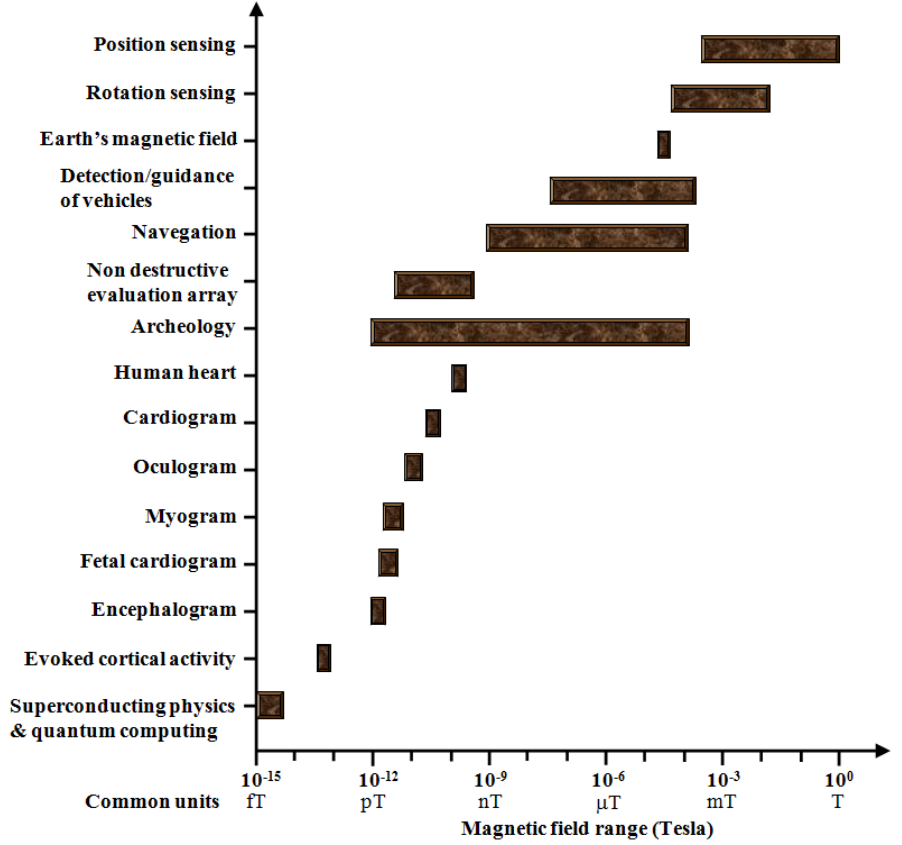
Figure 16. Typical magnetic signals range of several sources and applications [8,13,16,63].